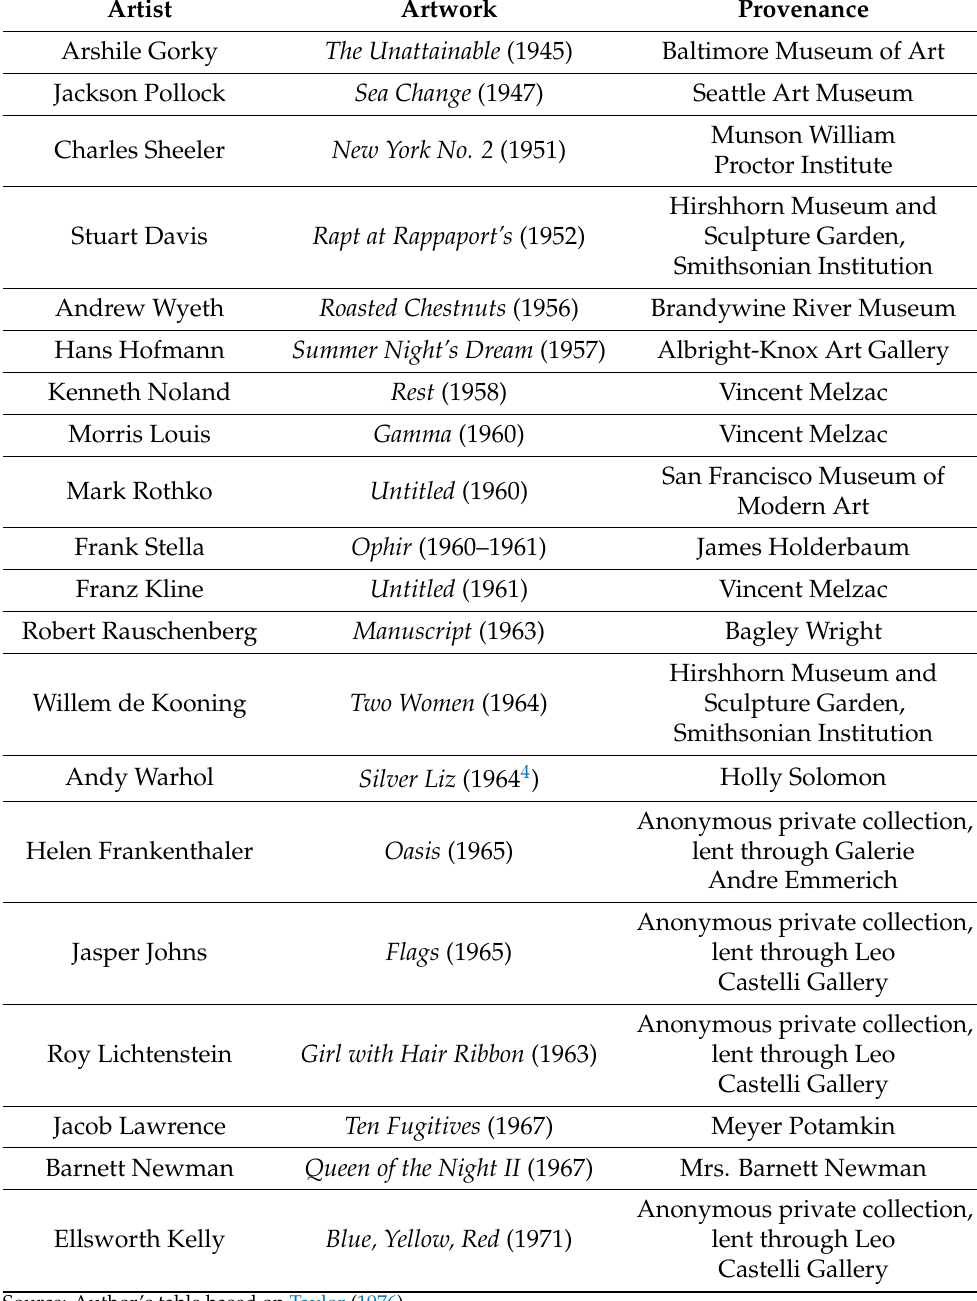
Table 1. American Modern Art in the “200 Years of American Painting”